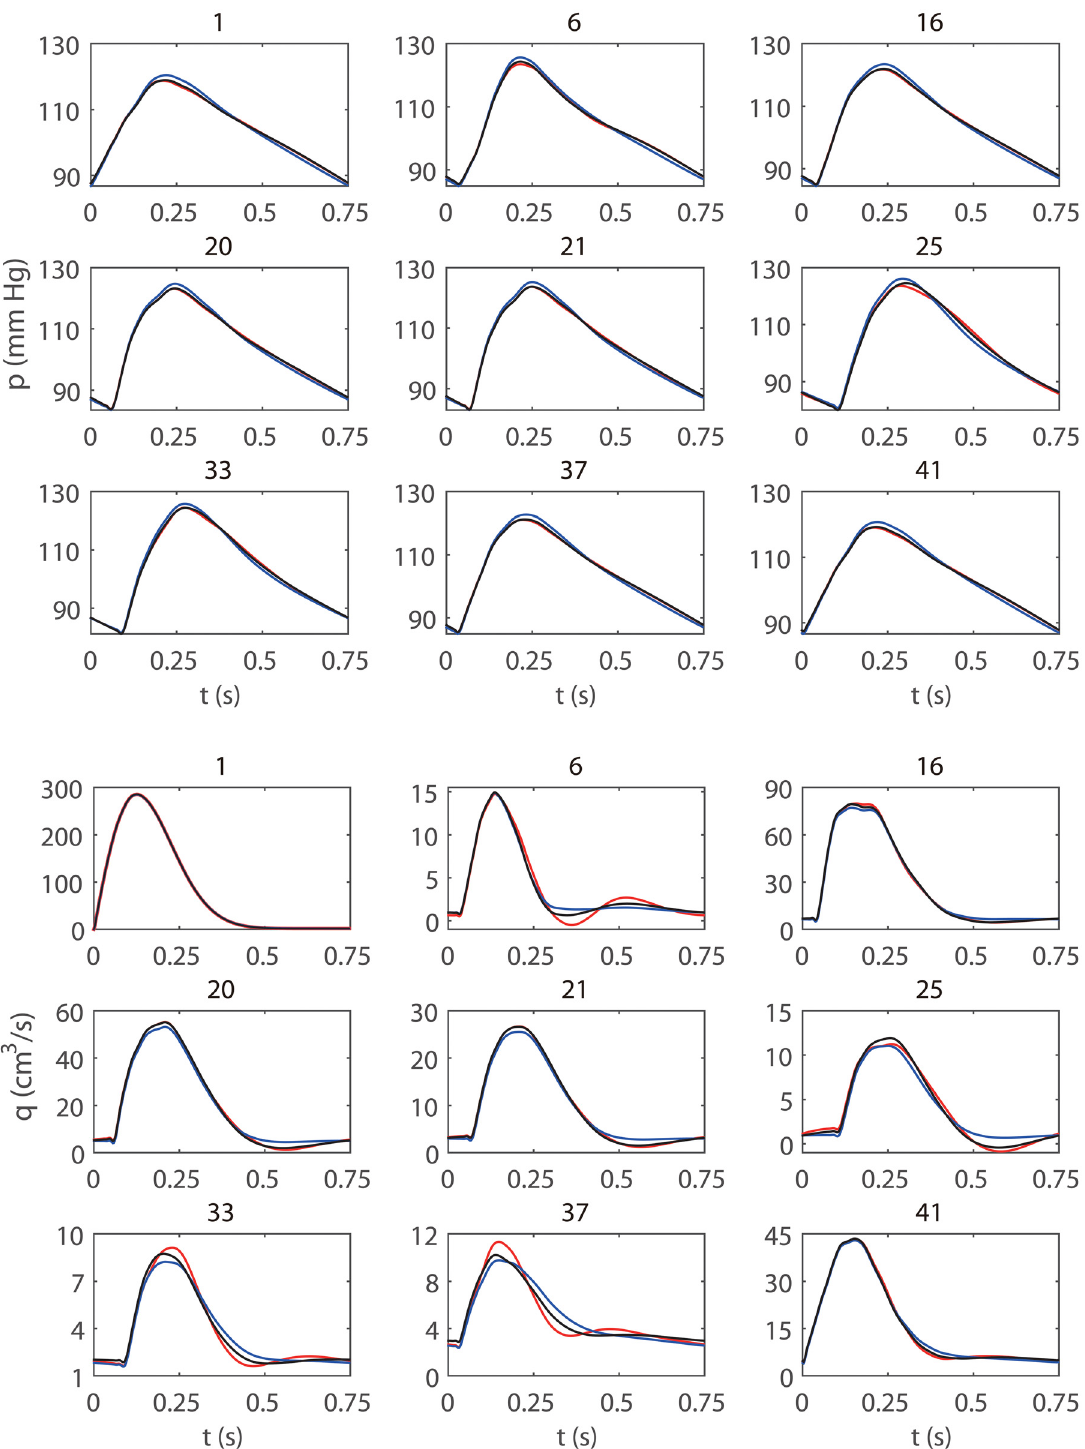
Fig 6. The blood pressures and flow rates in the systemic arterial tree. The line conventions are the same as those in Fig 4. The blood pressure and flow rate are measured at the midpoint of each of 9 representative vessels, whose corresponding vessel indices as listed in Table 2 are labeled on the top of each